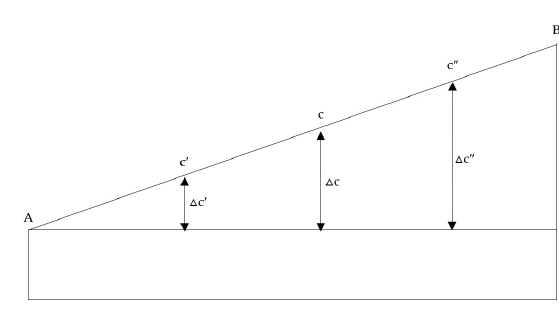
Figure 6. The comparison between contours